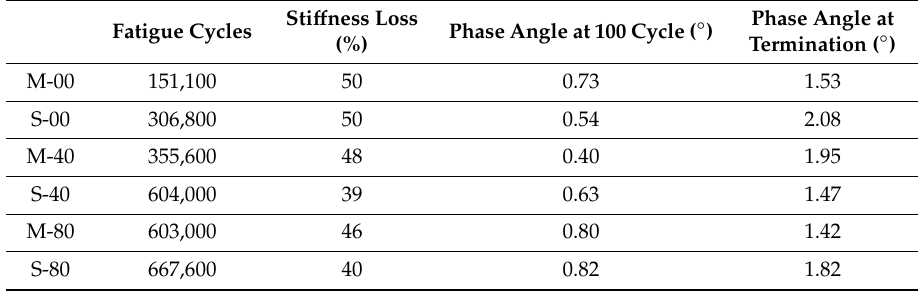
Table 6. Averages of sti ff ness modulus, dissipated energy and phase angle from fatigue tests.